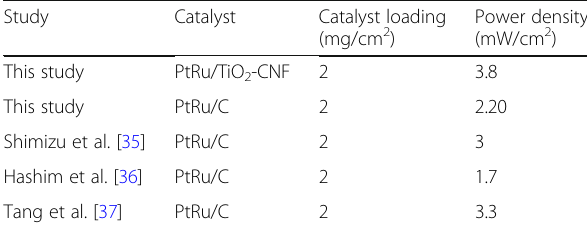
Table 7 Comparison of the single-cell performance results with the previous study